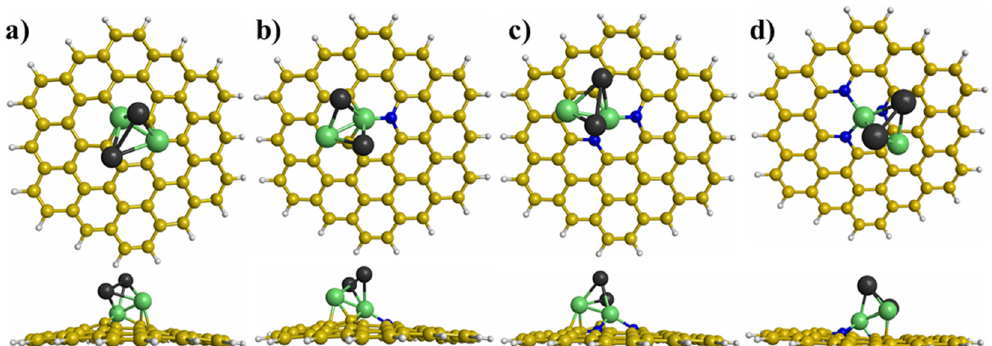
Figure 4. Top and side views of the most stable adsorption sites of the Ni 2 Pd 2 cluster on graphene with different defects: ( a ) graphene with a vacancy, ( b ) pyridinic N-doped graphene (PNG) with one N atom, ( c ) PNG with two N atoms, and ( d ) PNG with three N atoms.